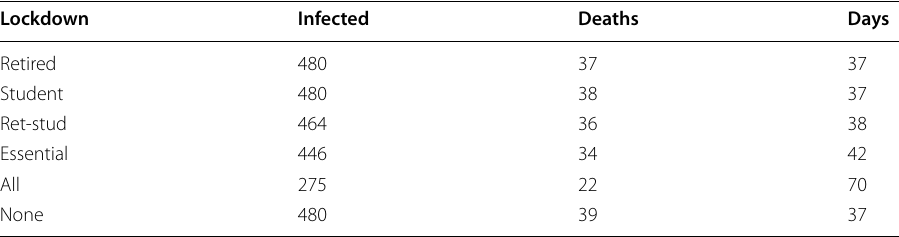
Table 4 Misinfodemic, with detection and without security measures